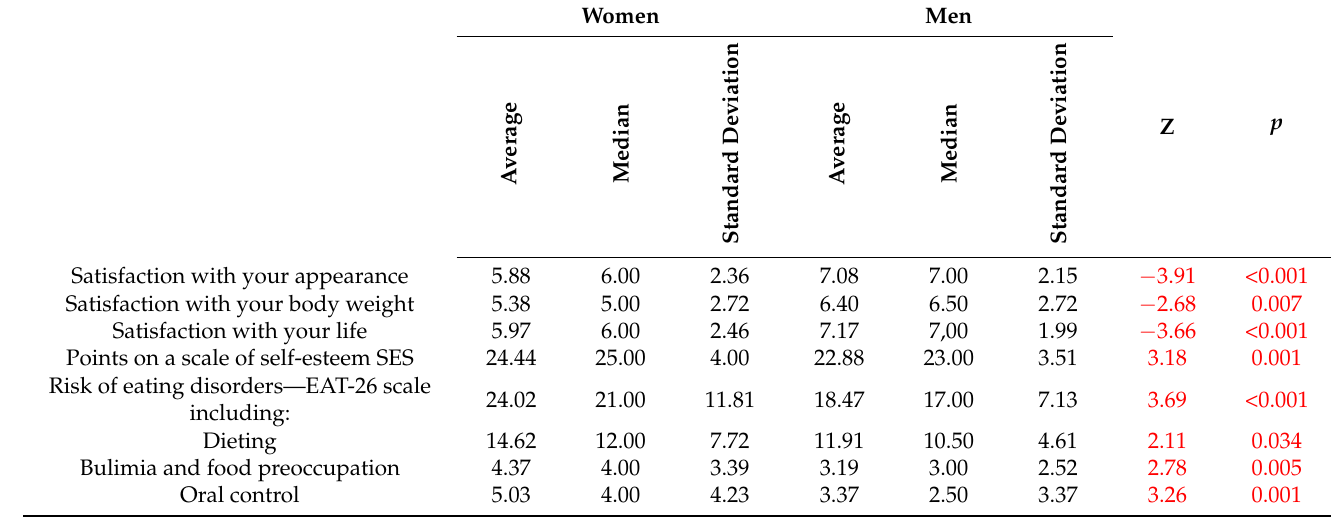
Table 1. Effects of gender on satisfaction with appearance, weight, life and risk of eating